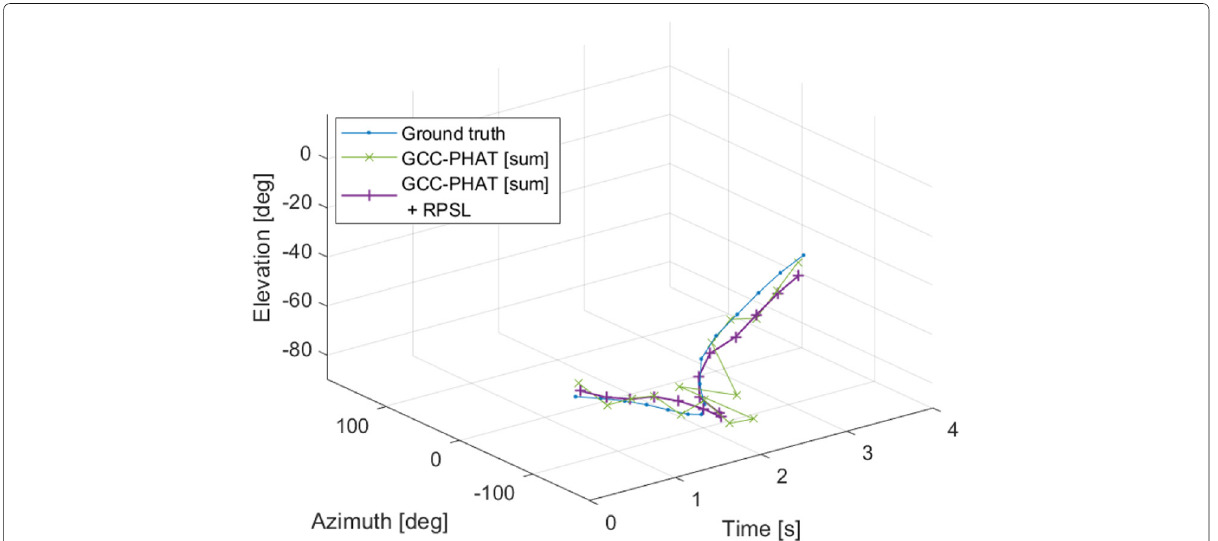
Fig. 12 Example of localisation path estimated for flying UAV broadband sound source (task 2) case 14 [1], using the baseline and proposed method (RPSL only)